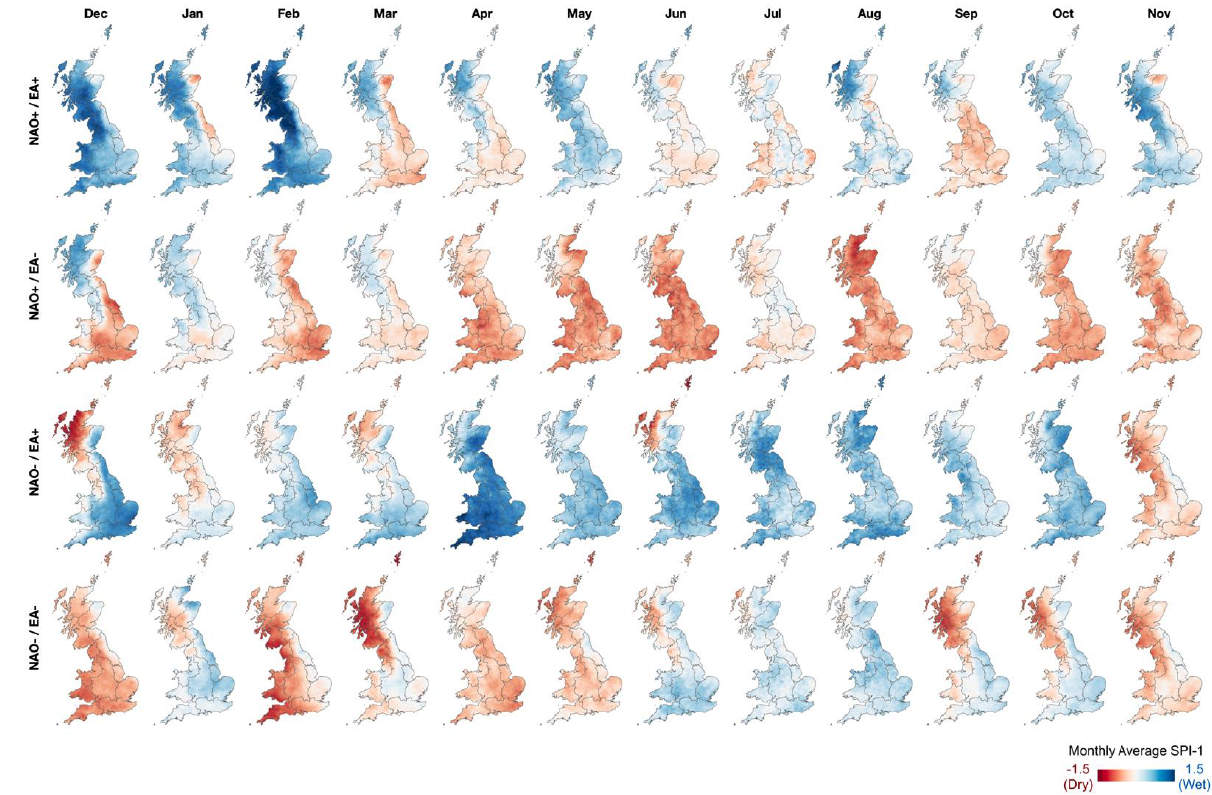
Figure 5. Average monthly SPI-1 values under different phase combinations of the NAO and EA. The convergence of the evidence presented in Figures 3–7 allows us to consider how the NAO and EA interact to influence average monthly regional rainfall spatial distribution and volume in Great Britain. As with the correlation analysis in Figure 2, the relative influence of the two teleconnections clearly varies in space and time. In the northern Climate Districts of Scotland North and West, the months with the highest average monthly rainfall occur during late autumn and winter and are clearly associated with NAO+ phases (Figure 5), with average monthly rainfall exceeding 200 mm (Figure 3). The highest average rainfall volumes are found in these regions when both the NAO and EA are in positive phases (Figure 4). Drier average conditions occur in the north-west when the NAO is in a negative phase, with average monthly rainfall in the region of 100–150mm; approximately half the average monthly rainfall as under NAO+ phases (Figure 3). In these two Climate Districts the NAO has a notable influence on average wet/dry conditions during